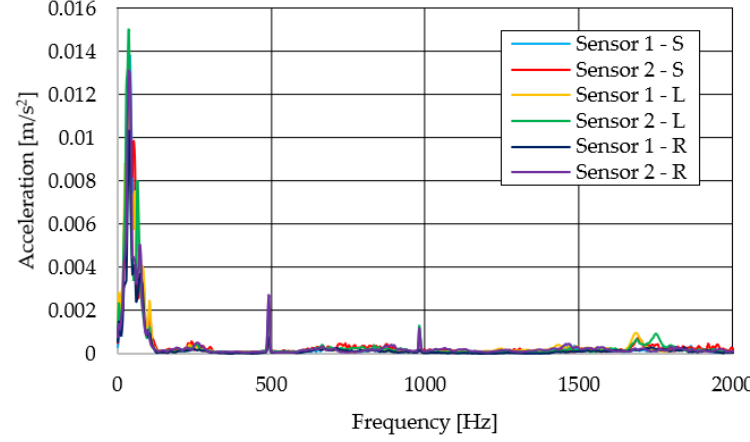
Figure 27. Comparison of the frequency waveforms in the y -axis.